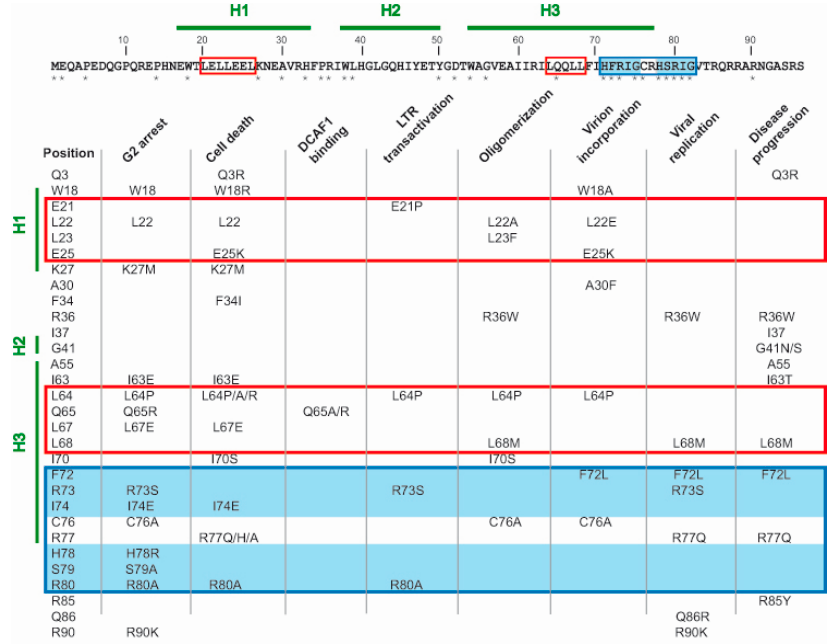
Figure 2. Summary of single sequence polymorphisms that have been associated with alteration in any of the activities of Vpr. The HXB2 Vpr represents the consensus sequence. * symbols indicate positions which have fully conserved residues in HIV-1 Vpr isolates from different M subtypes. H1, H2, and H3 refer to the three α -helices. Relevant residues are outlined in rectangles with the following color code: red = leucine-rich domain, blue = mitochondrial membrane permeabilization (MMP)-inducing sequence. The two HF/SRIG motifs are shadowed in blue.